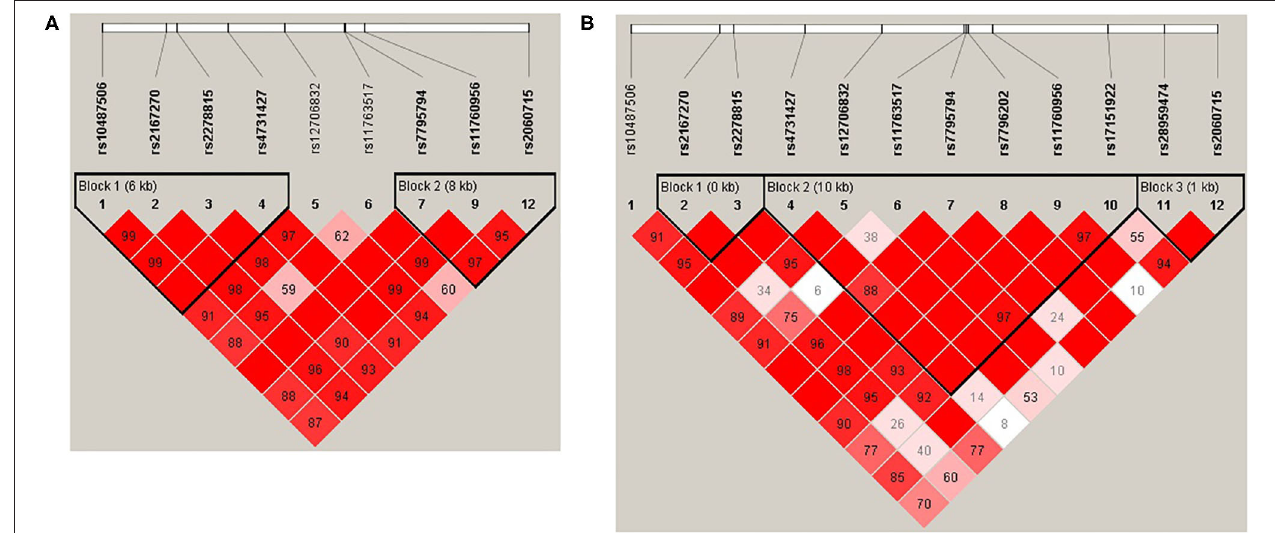
FIGURE 1 | (A) LEP linkage disequilibrium (LD) plot for the European American group. (B) LEP LD plot for the African American group. Pairwise LD is represented as red for strong LD, blue for non-significant LD, and white for little or no